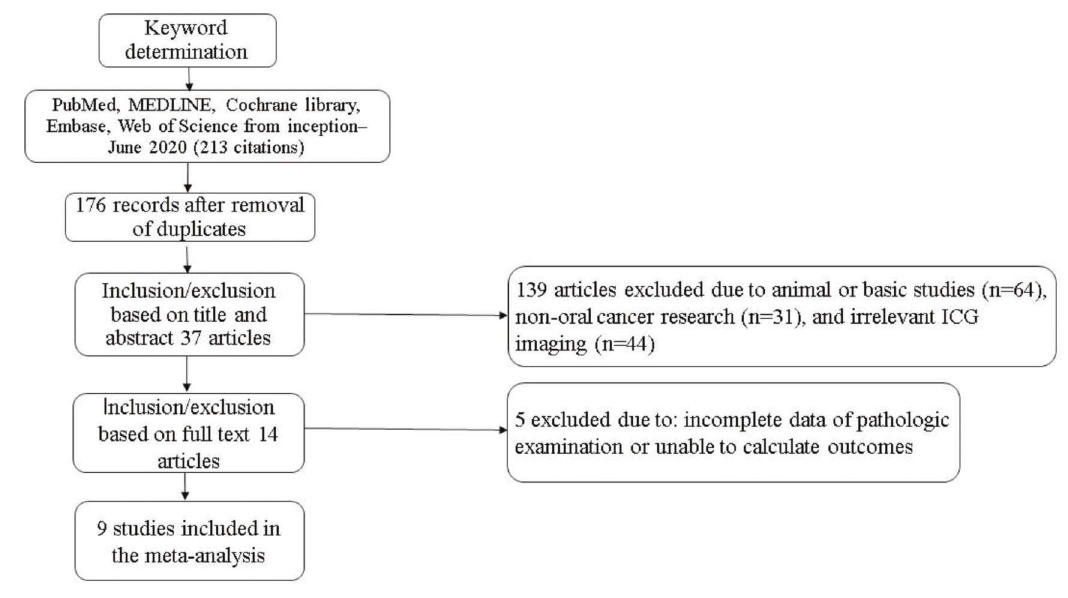
Figure 1 - Flowchart of study selection adapted from